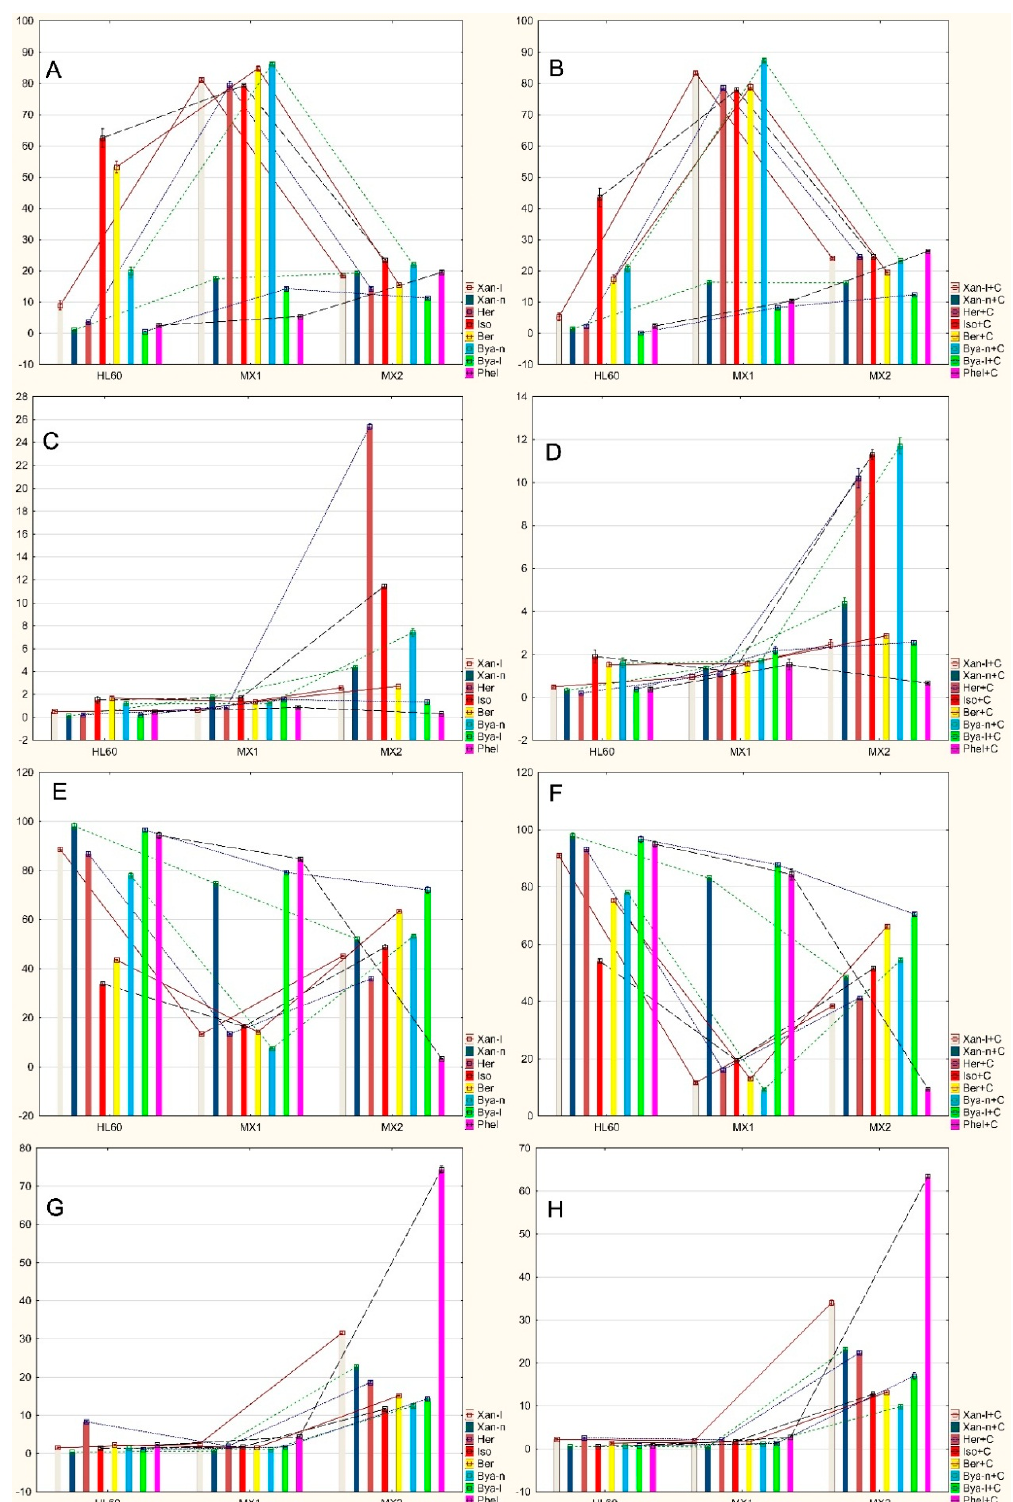
Figure 6. Statistically significant differences in the number of cells between the individual lines: HL60, HL60/MX1 and HL60/MX2 after exposure to the furanocoumarin compounds tested without mitoxantrone ( A —number of life cells; C —number of early apoptotic cells; E —number of late apoptotic cells; G —number of necrotic cells) or with mitoxantrone ( B —number of life cells; D —number of early apoptotic cells; F —number of late apoptotic cells; H —number of necrotic cells).